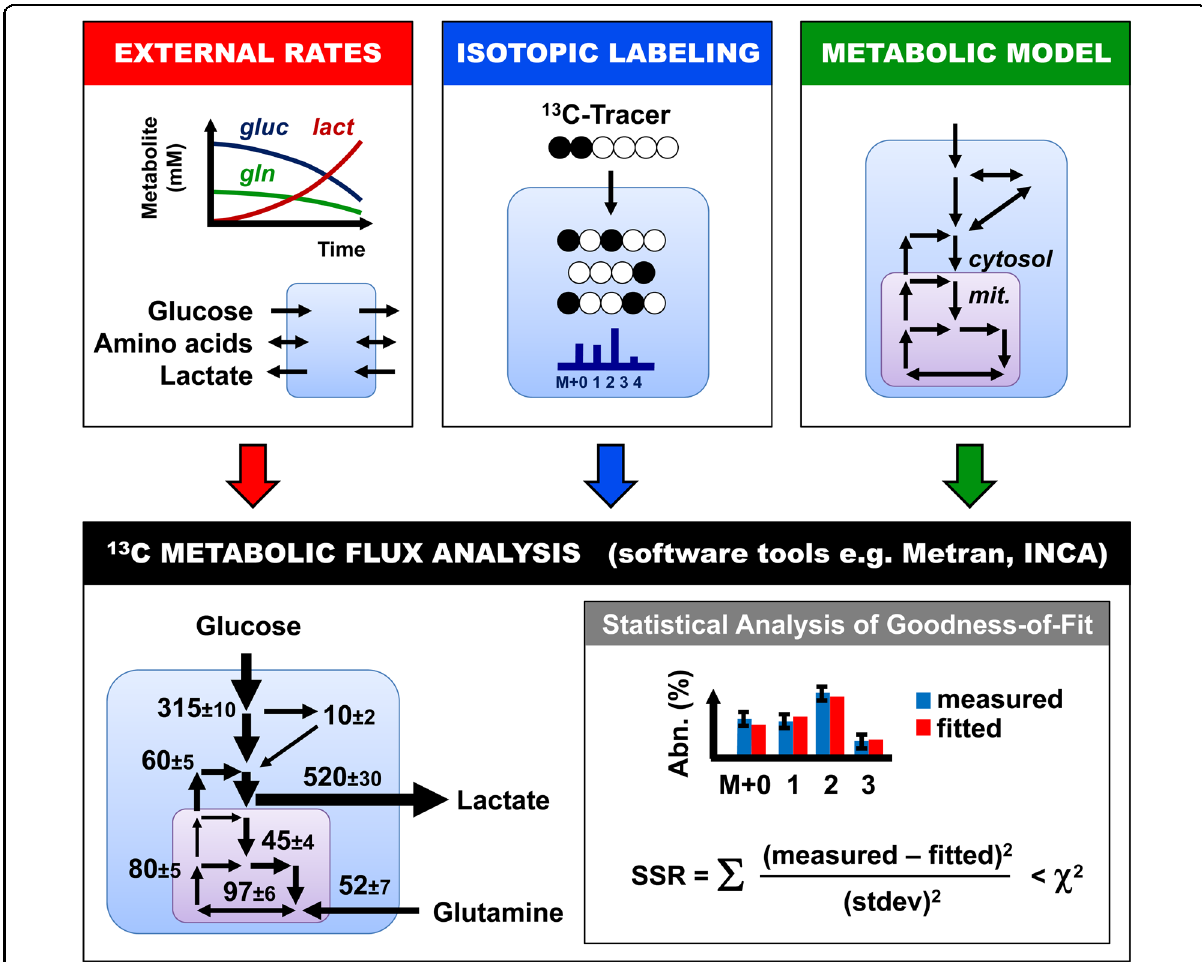
Fig. 2 13 C metabolic fl ux analysis ( 13 C-MFA) is a powerful approach for quantifying intracellular metabolic fl uxes in cancer cells. The three inputs required for 13 C-MFA are external uptake and secretion rates, isotopic labeling measurements, and a comprehensive compartmentalized model of cellular metabolism. User-friendly software tools for 13 C-MFA, such as Metran and INCA, can be used to perform 13 C-MFA calculations. These tools produce as outputs fl uxes for all reactions in the model, con fi dence intervals for the estimated fl uxes, and statistical analysis of the goodness-of- fi